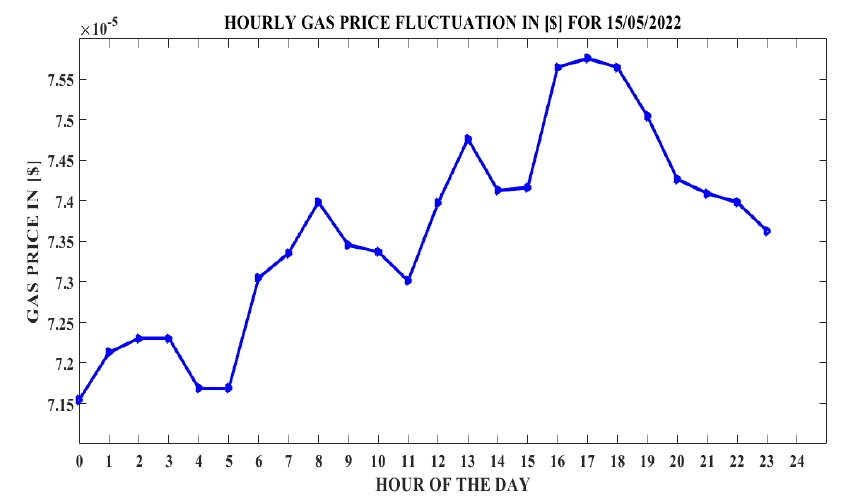
Figure 6. Hourly gas price fluctuation in US Dollars for 15 May